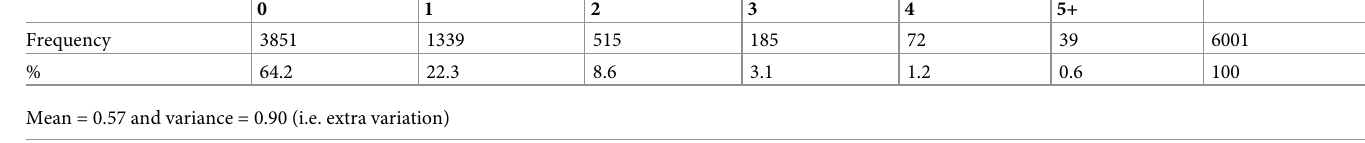
Table 2. Distribution of the number of pregnancy complications among the urban women in Bangladesh.